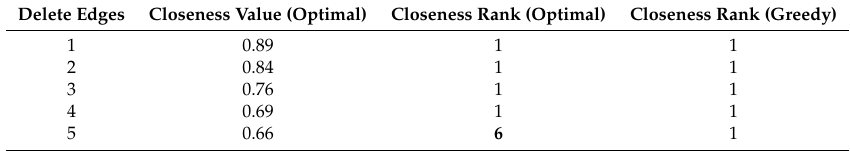
Table 2. The simple example to compare the closeness value cases with the rank